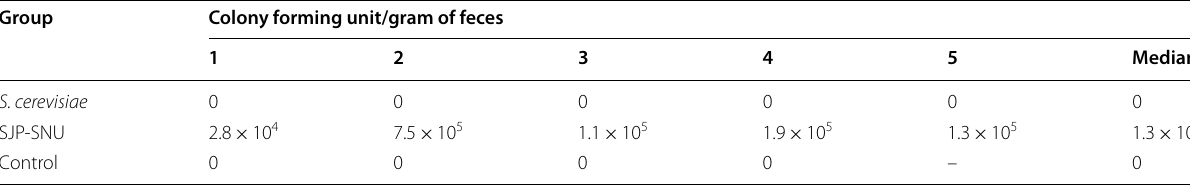
Table 1 Intestinal viability of S. cerevisiae and SJP-SNU in chickens